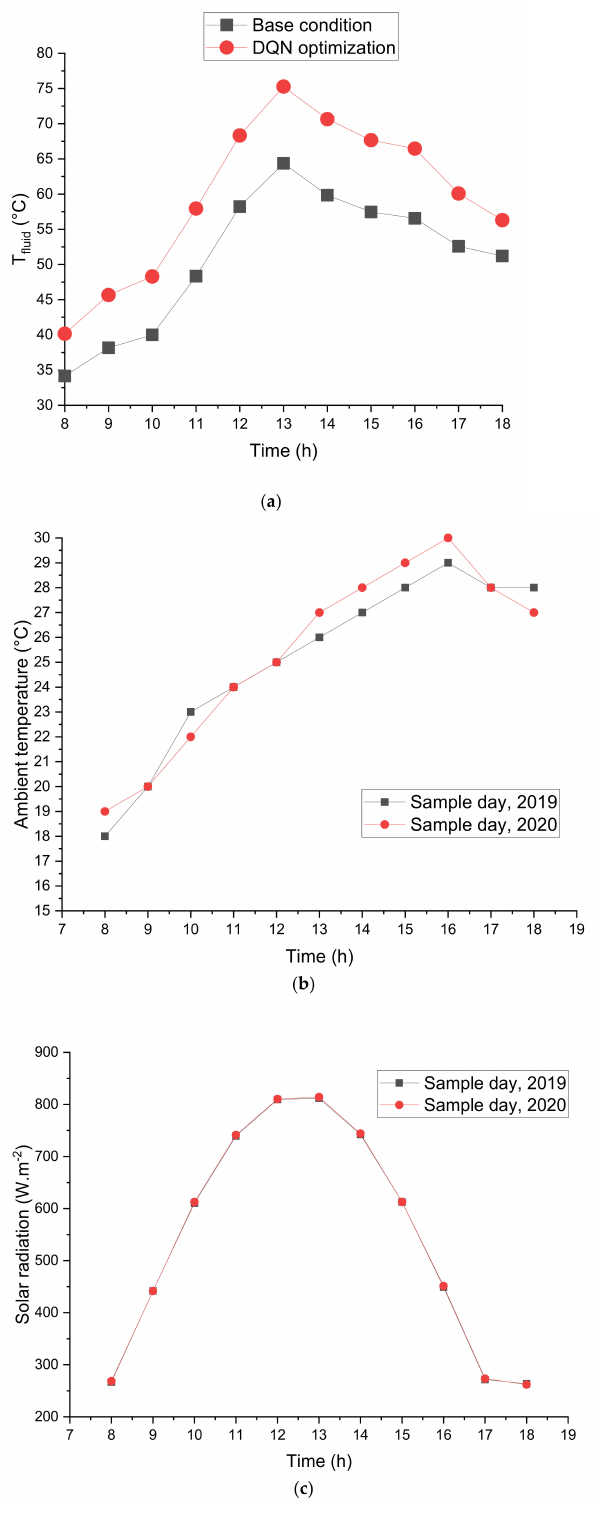
Figure 5. The hourly variations in ( a ) T fluid ; ( b ) ambient temperature; ( c ) solar